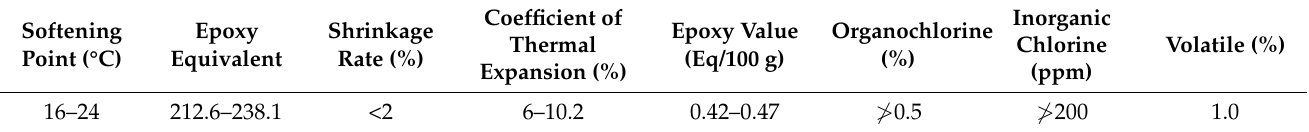
Table 2. Technical properties of E-44 epoxy